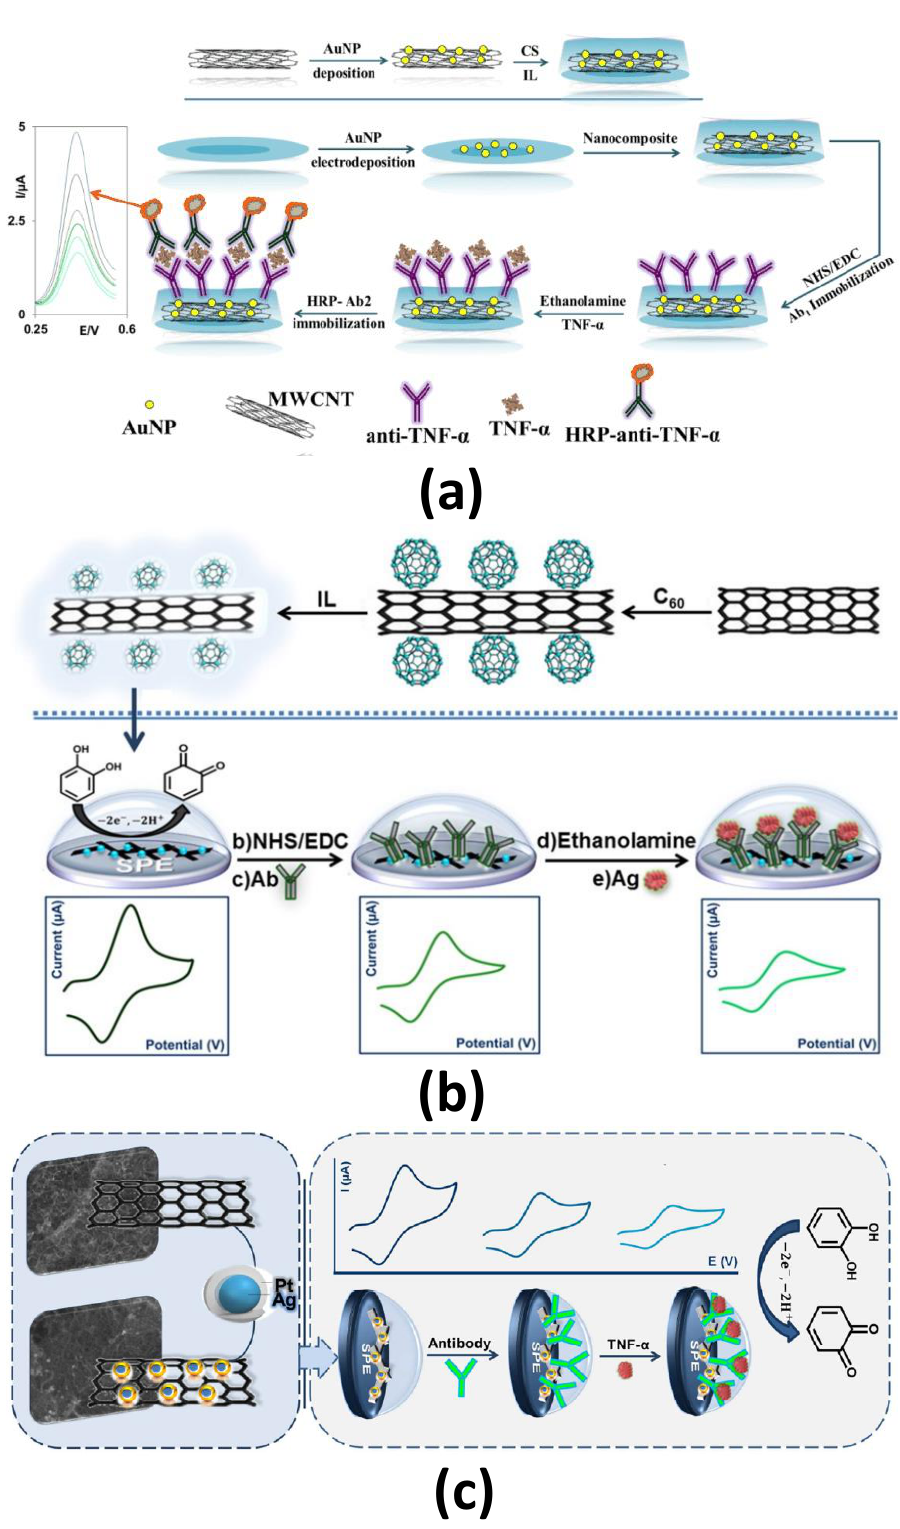
Figure 7. Integrated immunosensors for the determination of TNF- α using ( a ) AuNP/MWCNT- AuNP nanocomposite/IL-CS composite film, ( b ) Ag@Pt-CNTs-CS and ( c ) C 60 -CNTs-IL nanocompos- ites as electrode modifiers. Reprinted from ( a ) [20] ( b ) [21] and ( c )